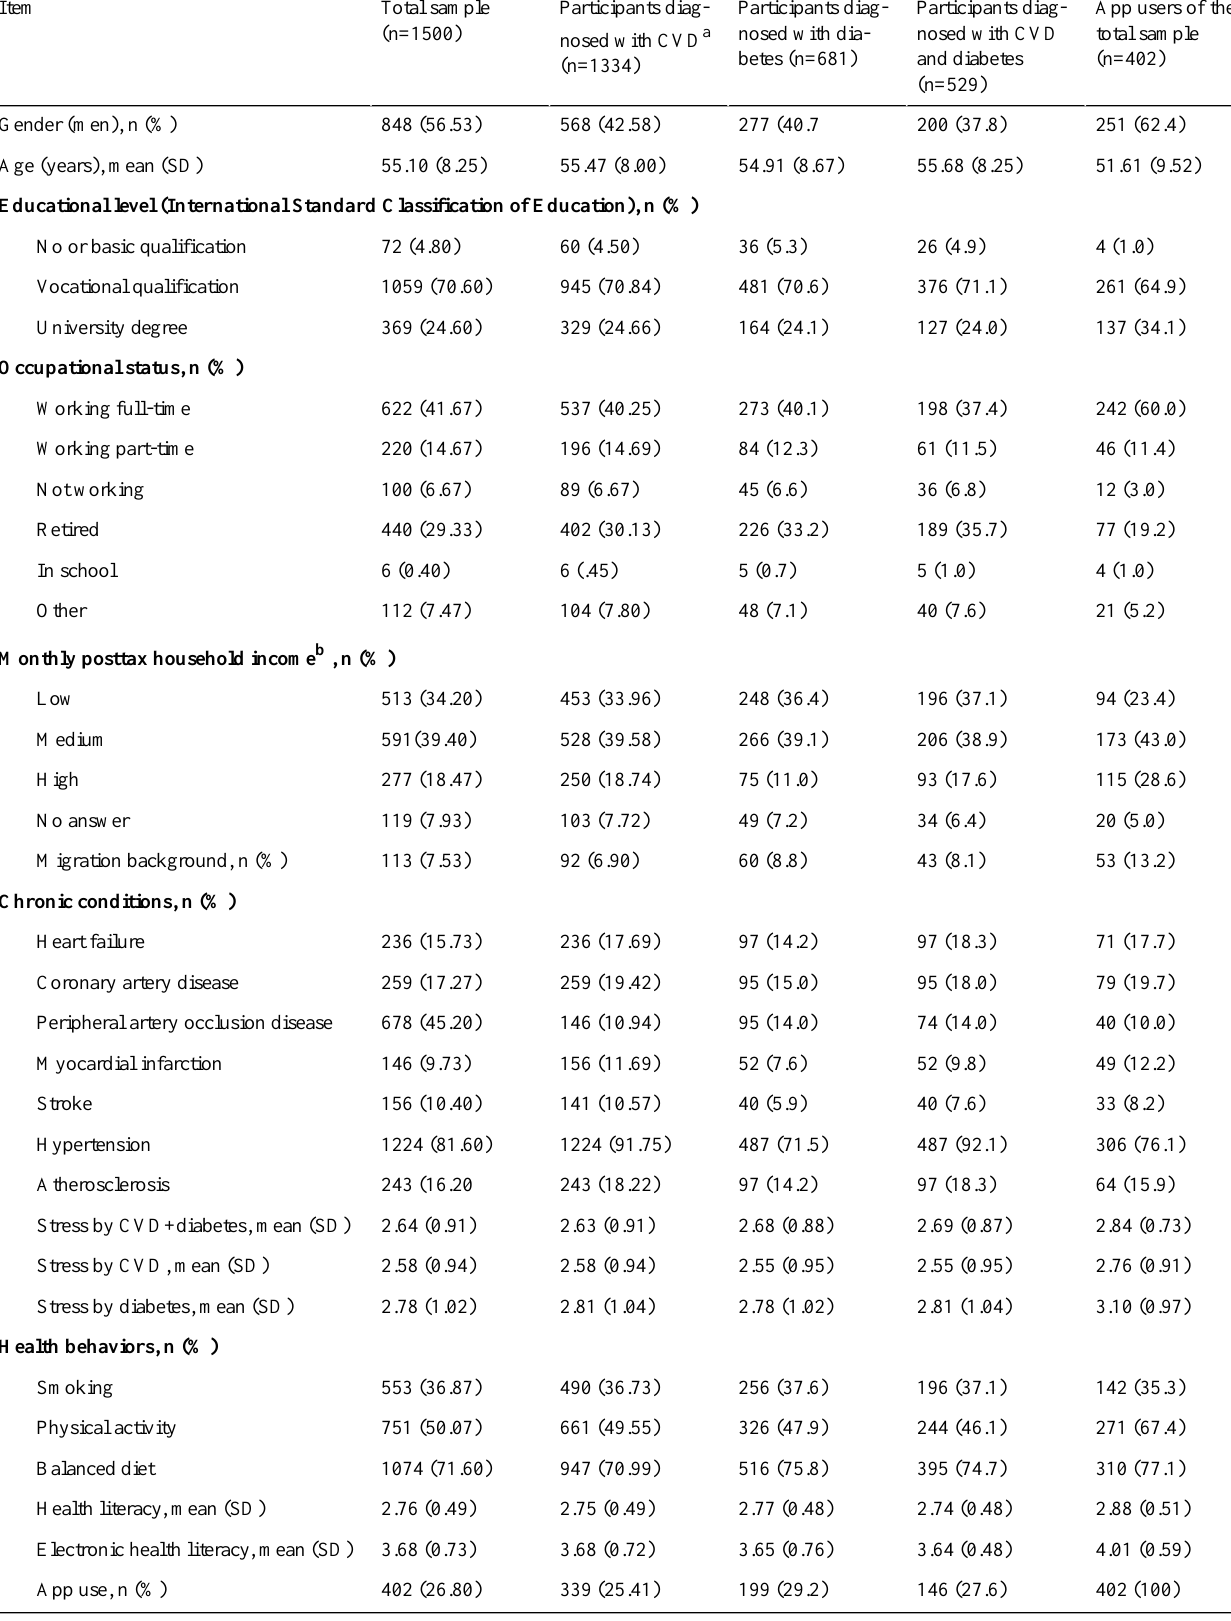
Table 1. Sample characteristics by subgroups